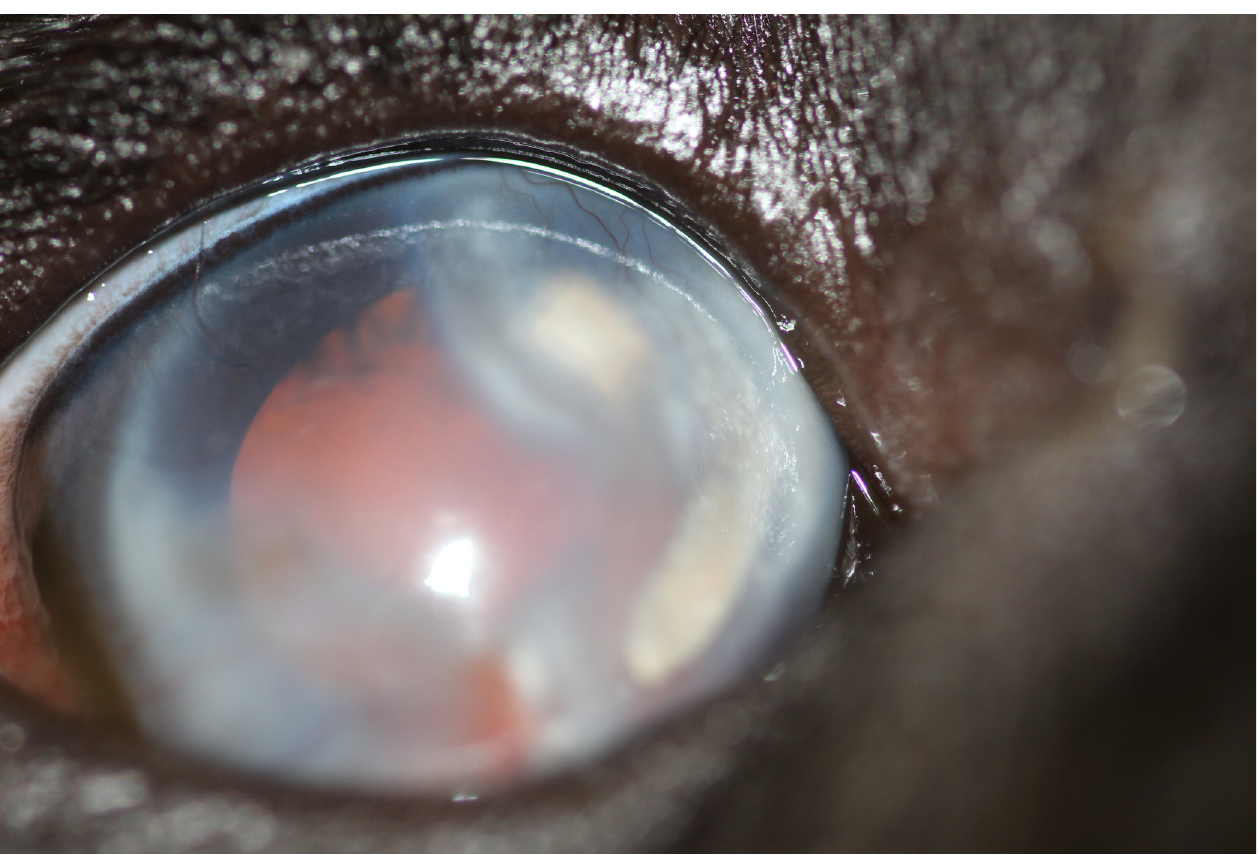
Fig 5. Ocular defects associated with affected ECS. Showing corneal and lenticular abnormalities.